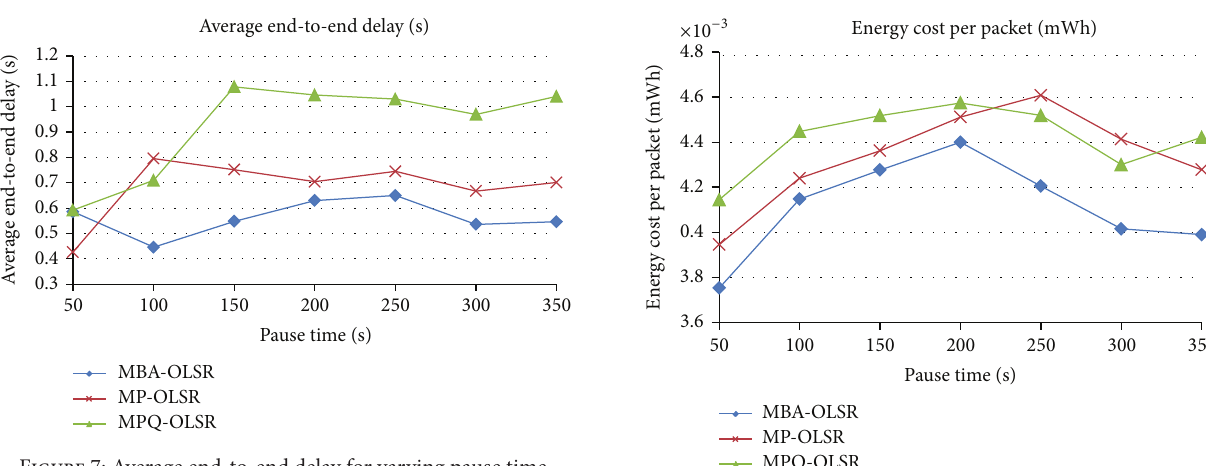
Figure 7: Average end-to-end delay for varying pause time.